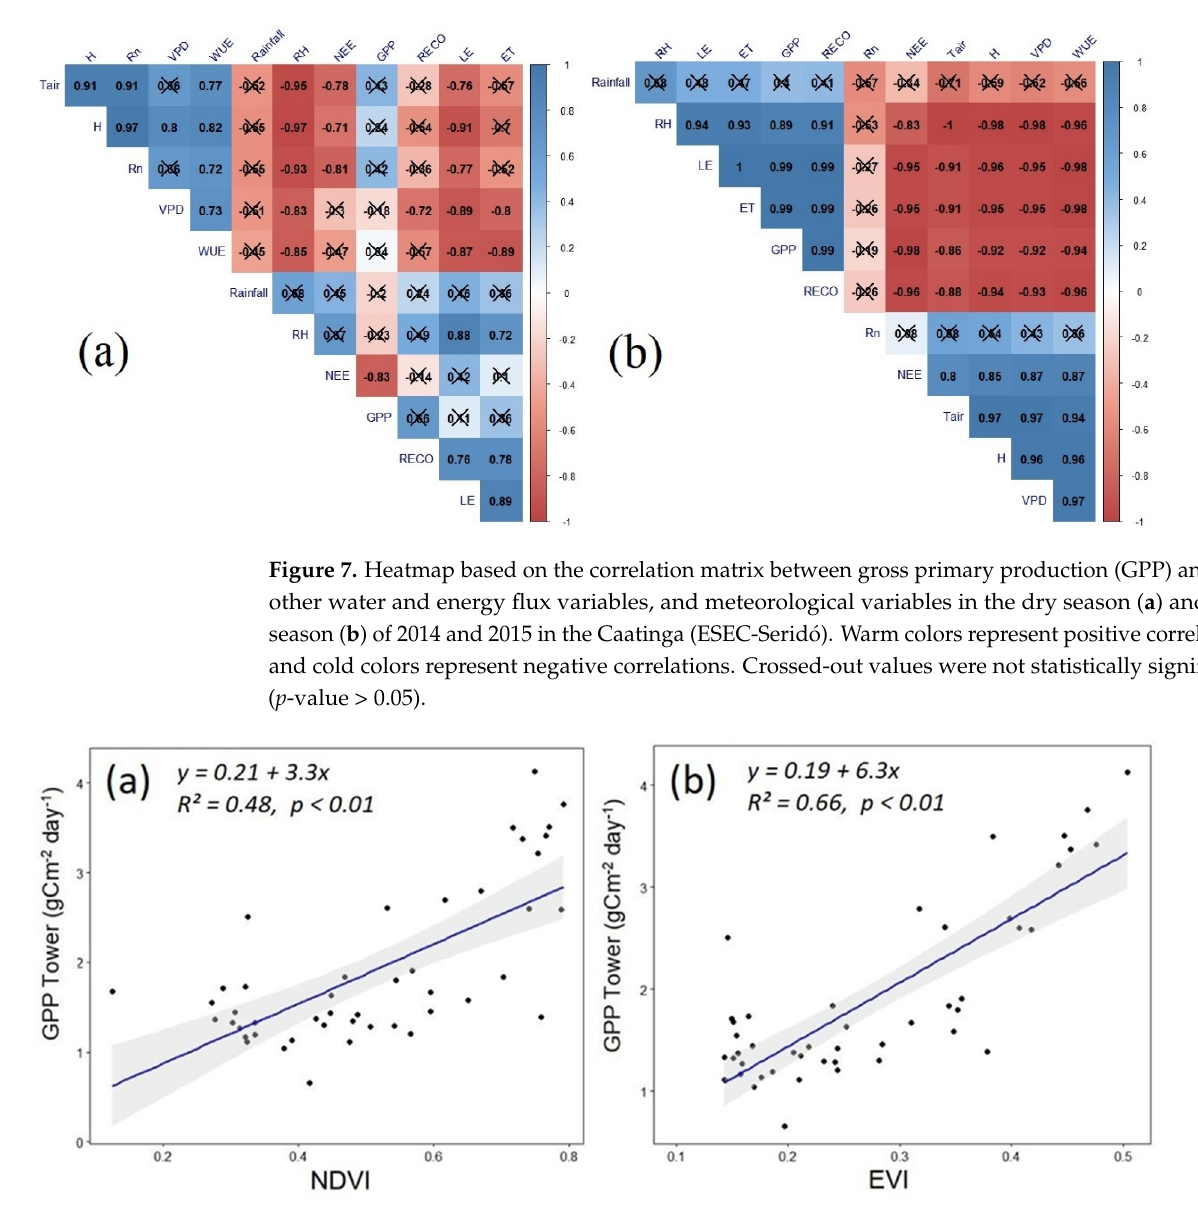
Figure 8. Relationship between measured gross primary production (GPP Tower) and the two vegetation indices (NDVI ( a ), EVI ( b )) for the ESEC-Seridó site. Gray bands represent the 95% confidence interval for the fitted linear model.